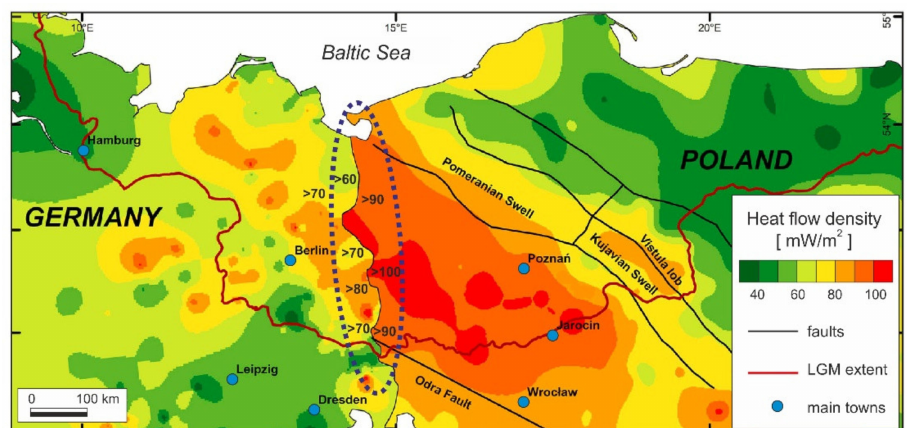
Figure 11. Compilation of heat flow map across the Germany–Poland border (modified and redrafted, based on Szuman et al., [55] data compilation from Global Heat Flow database for Germany data and heat flow for Poland from Szewczyk and Gientka [17]). Dotted blue line ellipse highlights the sharp jump of Q values at the border of Poland and Germany observed and highlighted here in this paper and this figure. The LGM red line shows the southern extent of the last glacial maximum at about 20–24 ka BP [50]. Note: the highlighted heat flow ‘jump’ at the political border is highly